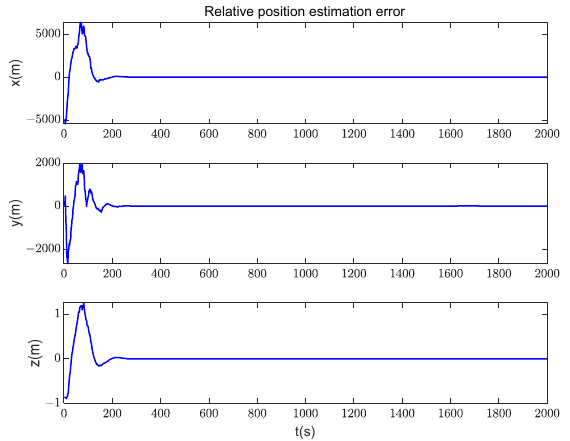
Figure 11. Comparison of relative velocity parameters.